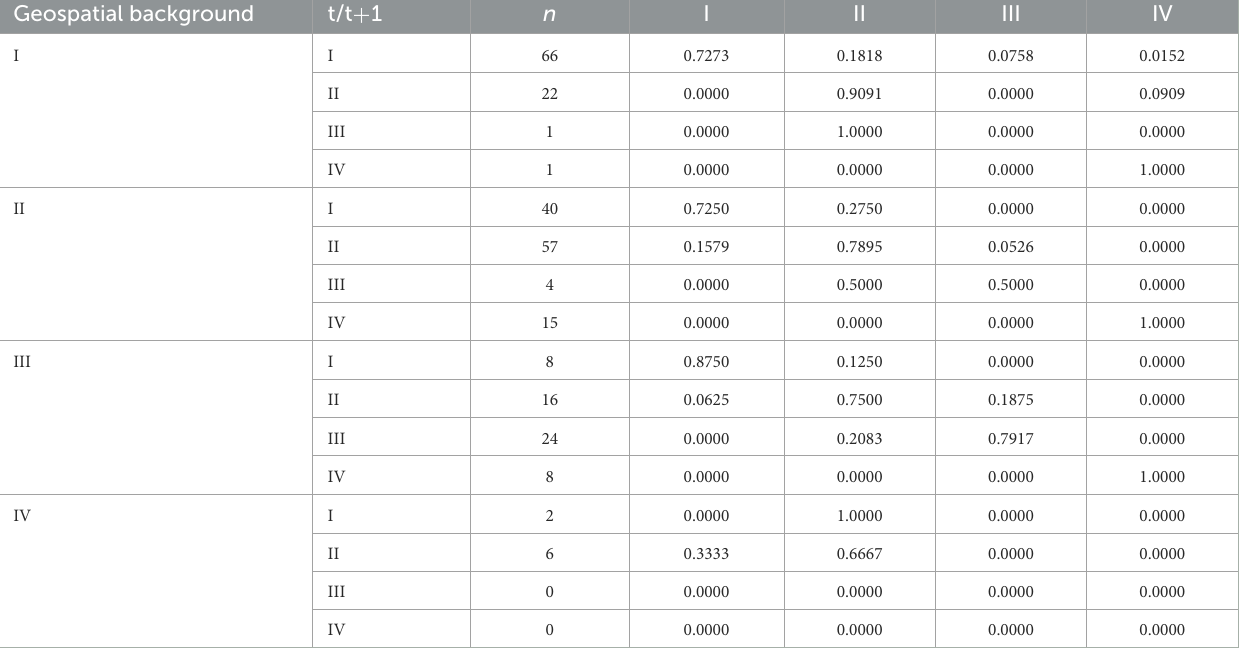
TABLE 6 Spatial Markov probability matrix for tourism ecosystem health types in China from 2011 to 2020. Geospatial